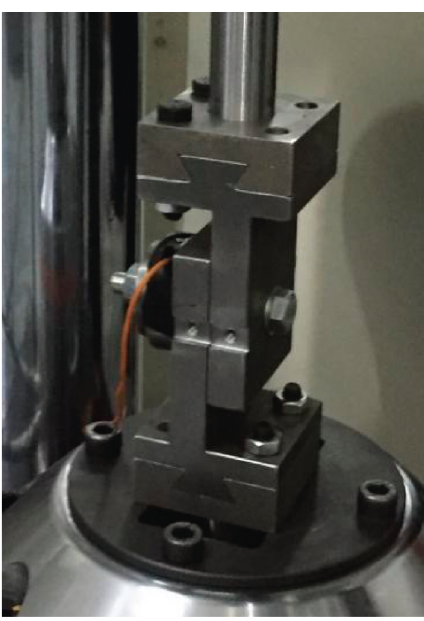
Figure 5: Test device installation. Table 2: Annular pressure sensor